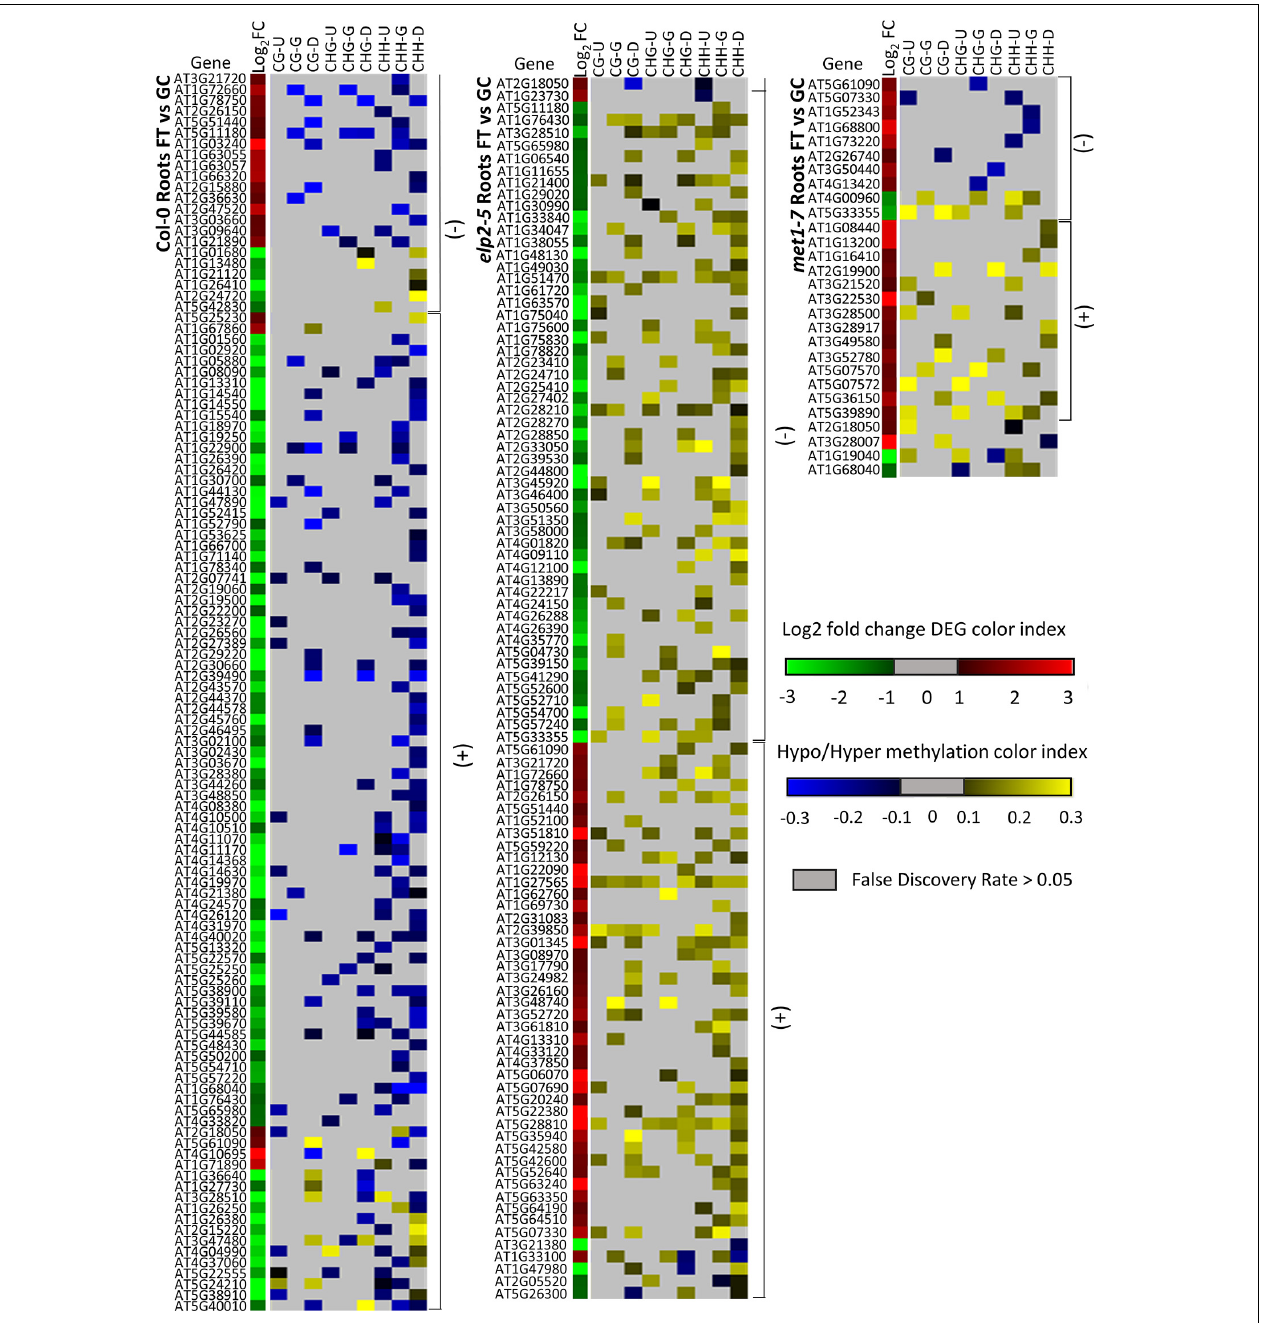
FIGURE 11 | Heatmap of spaceflight (FT) vs ground control (GC) DEGs-DmCs in Col-0, elp2-5 , and met1-7 roots. Heat maps show the Log 2 (Fold-change) of differential gene expression (red: up-regulated and green: down-regulated) and differential DNA methylation (hypermethylation: yellow and hypomethylation: blue) of Col-0, elp2-5 , and met1-7 roots in FT compared to GC. DmCs for each CG, CHG, and CHH methylation context in each genic region (Gene body: TSS to TTS, upstream: 2 kb from TSS, downstream: 2 kb from TTS) are denoted in the heat maps. The heatmaps show both negative and positive correlations of DEGs with DmCs. Negative correlations ( − ) are defined when up-regulated genes aligned with hypomethylated DmCs and down-regulated genes aligned with hypermethylated DmCs. The converse relationship is indicative of a positive correlation (+).